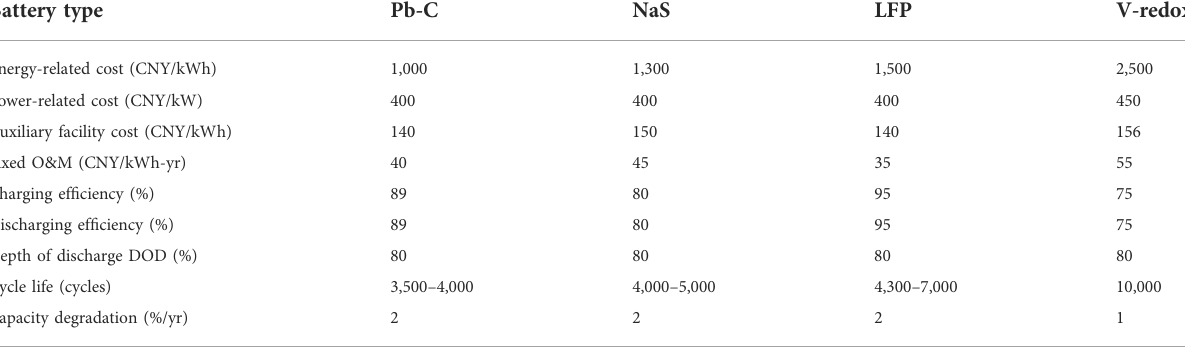
TABLE 1 Costs and technical performance parameters of four kinds of battery energy storage on the user side. Battery type